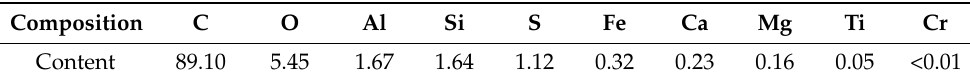
Table 7. Coke composition (wt.%).